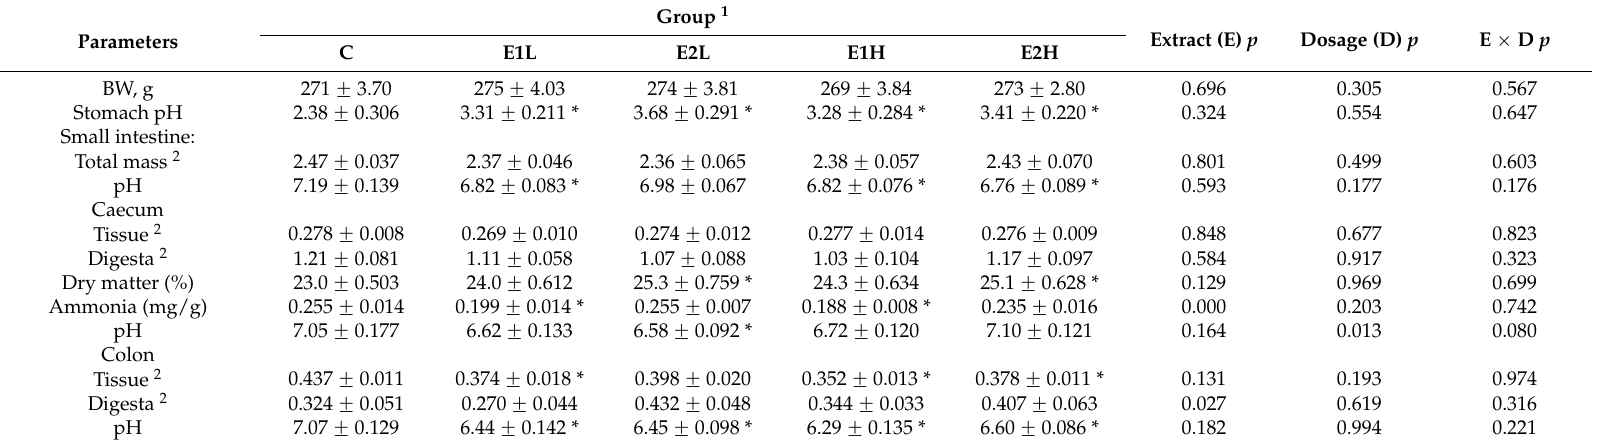
Table 1. Body weight (BW) and basic indicators of the gastrointestinal function of rats.